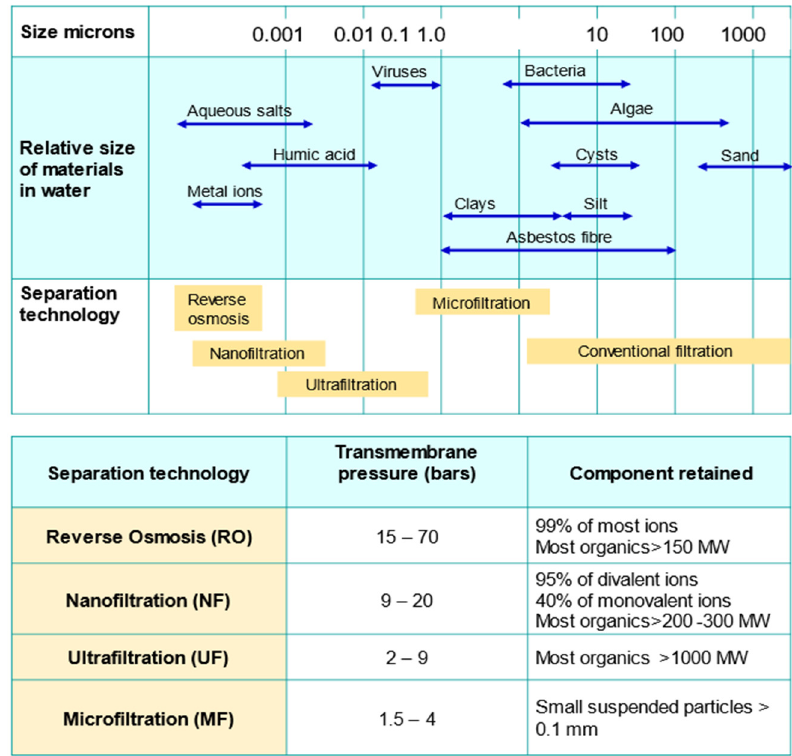
Figure 2. Membrane processes and application.